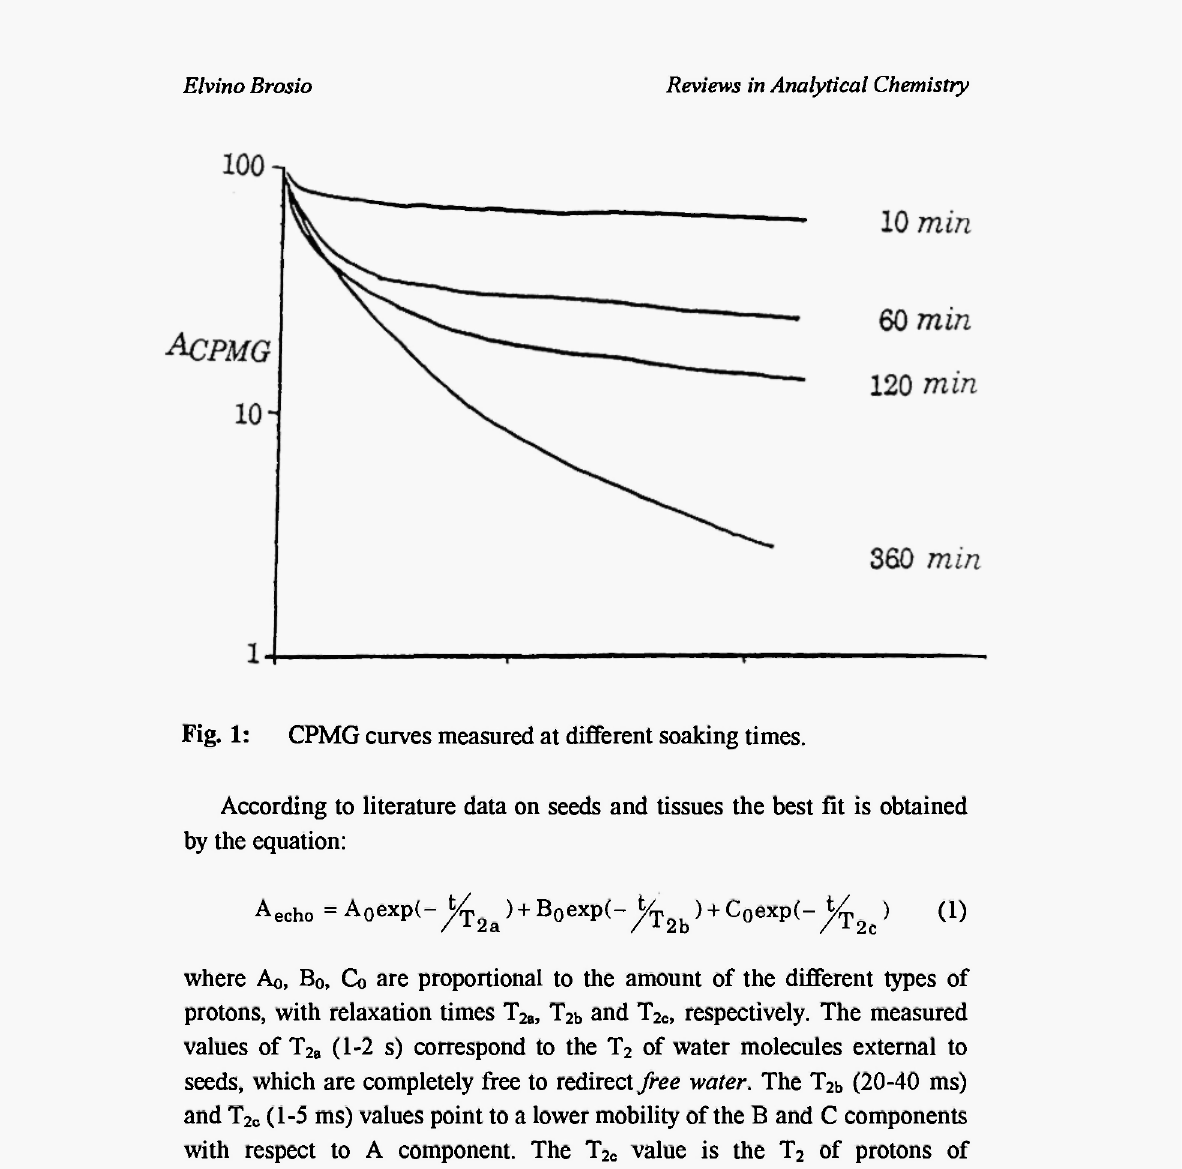
Fig. 1: CPMG curves measured at different soaking